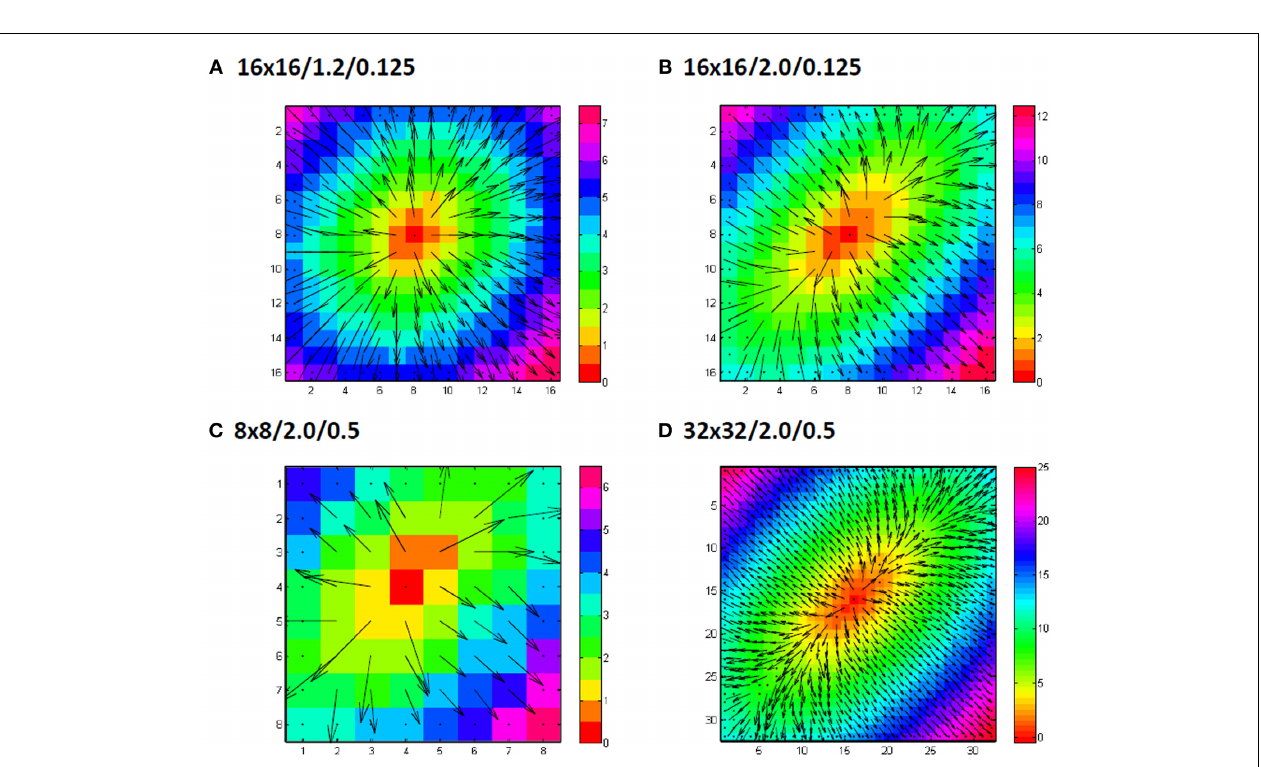
FIGURE 5 | Examples of grid sizes and anisotropic conduction velocity ratios. Numbers indicate grid size/anisotropy ratio/added noiselevel in ms. In panel (A) an example of a 16 by 16 grid is shown for an anisotropy ratio of 1.2 (0.9m/s longitudinal and 0.75m/s transversal) with only 0.125ms gausian noise added to the simulated